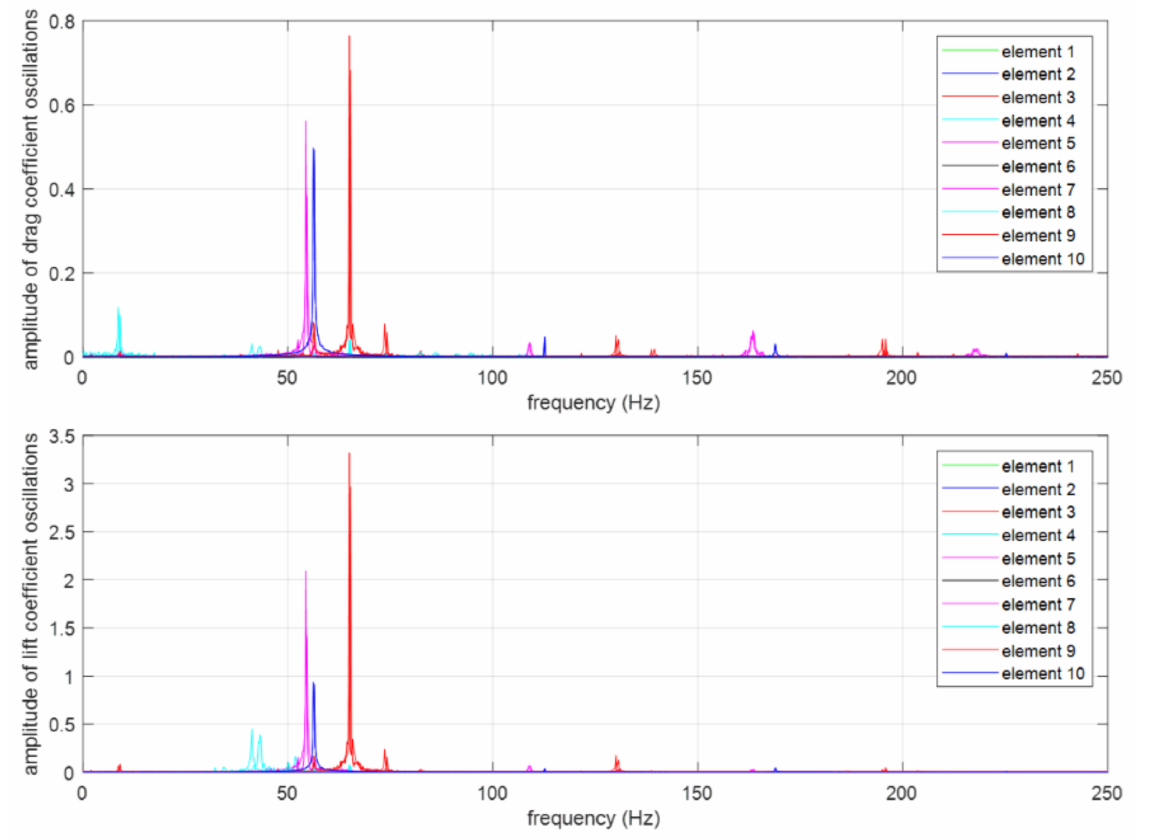
Figure 16. Amplitude spectrum (result of a FFT) for the oscillations in drag ( top ) and lift ( bottom ) coefficient for each of the helideck frame elements, for an incident wind speed of 27.1 m/s (the results for the frame elements have been colour coded based on the symmetry of their